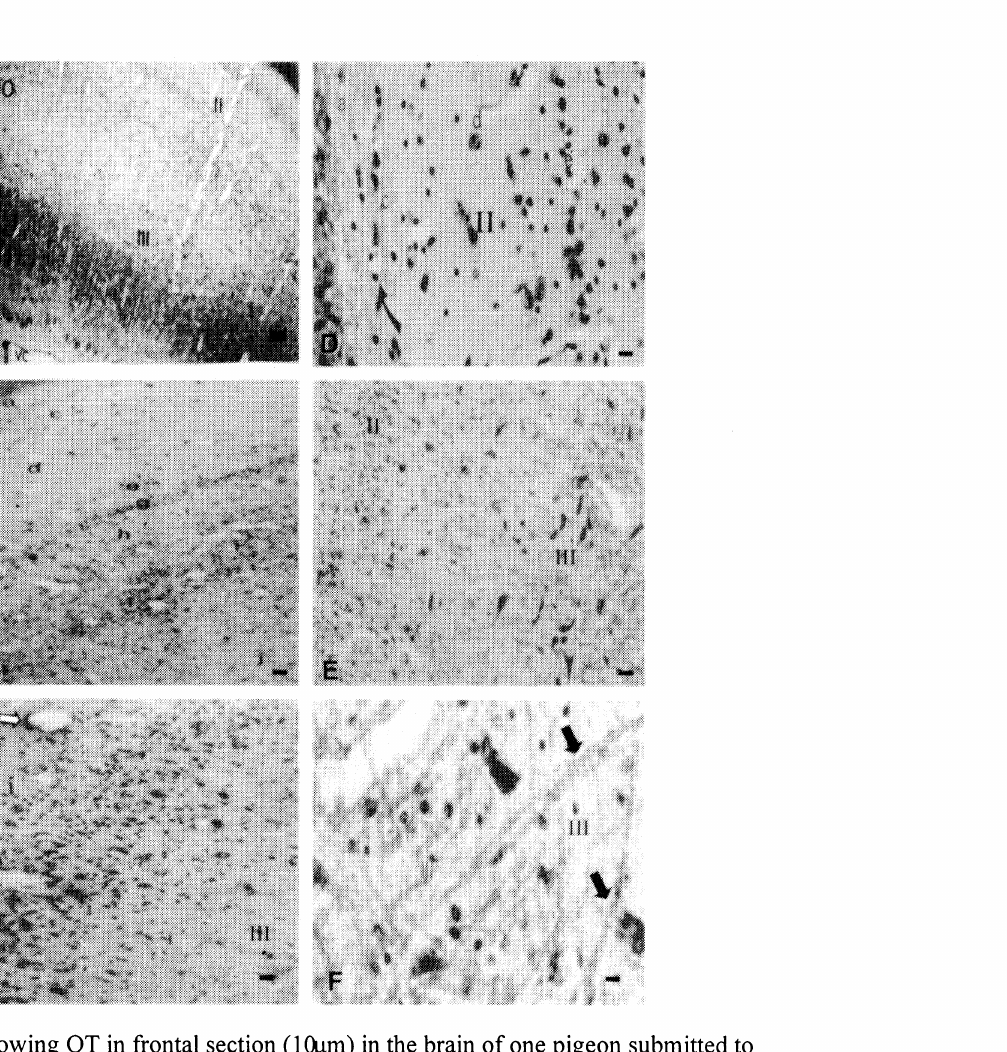
Fig. 9: Microphotographs showing OT in frontal section (lm) in the brain of one pigeon submitted to detelencephalation lesion (Exp). Cell bodies and myelined fibers were visualized using KlBver-Barrera technique. Layer I- VI (A) layer II (B, C, D, E), layer III (C, E, F). Subdivisions of layer II are directly indicated by letters a-j. The animals were sacrificed 120 days after surge. A= 10m; B, C= 20m; E D, F: